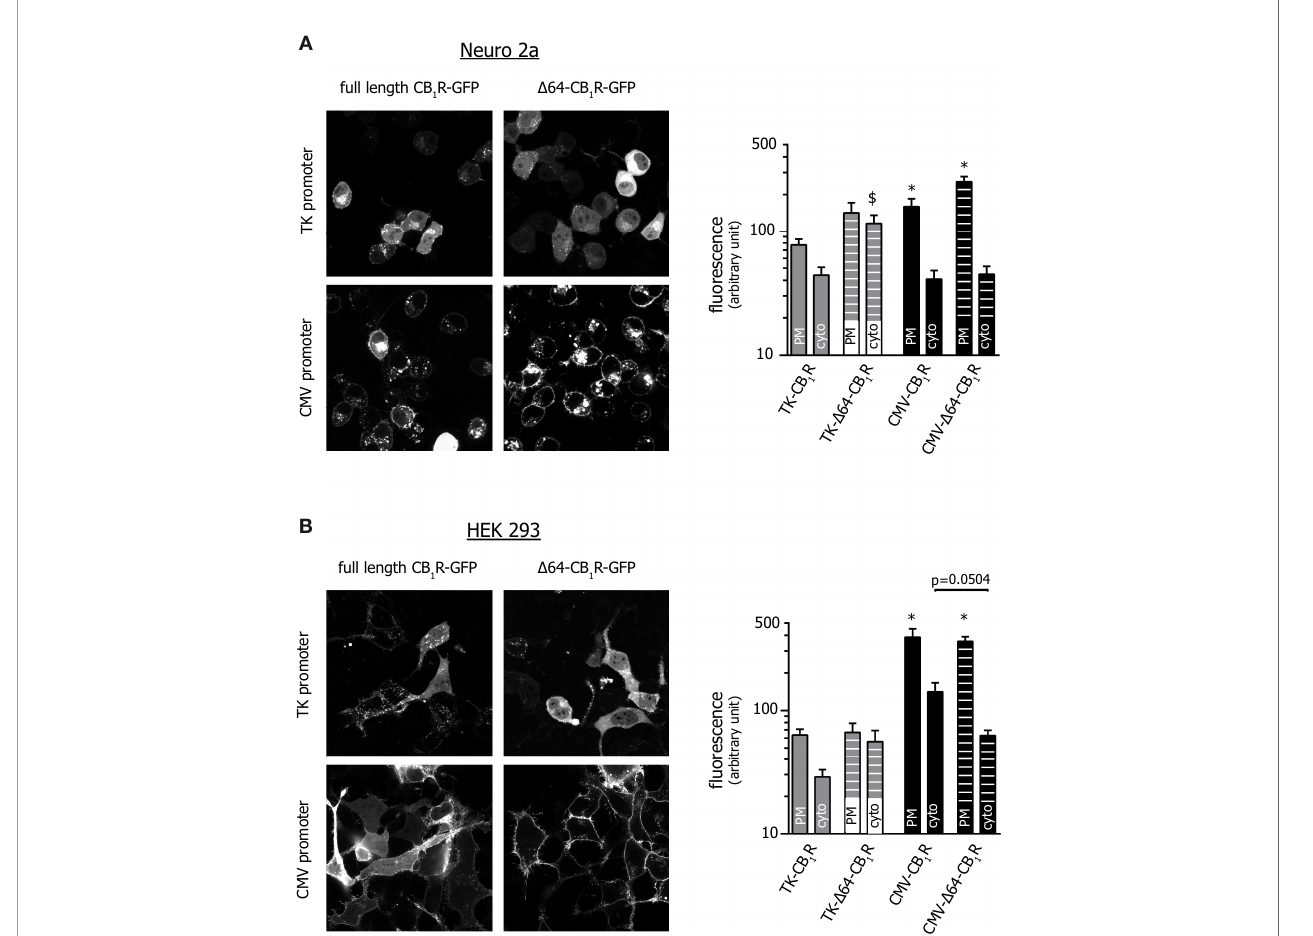
FIGURE 3 | Confocal microscopic assessment of the localization of various CB 1 R mutants. Images of Neuro 2a (A) and HEK 293 (B) cells expressing GFP-tagged versions of the pertinent CB 1 receptor variants were acquired with spinning disk confocal microscopy along the entire z-axis of the cell. Slices positioned at the bottom 1/3 ( i.e. close to the cell-coverslip interface) are presented and show an area of approx. 100 x 100 µm. (Please note that due to the signi fi cant differences in expression, the brightness of images showing TK promoter-driven receptor variants was increased to a higher extent.) Bar graphs show average plasma membrane and cytosolic fl uorescent intensity after background subtraction. In all groups n=16; *p < 0.05 when compared to TK-CB 1 R PM (one-way ANOVA followed by Dunn ’ s or Holm-Sidak ’ s multiple comparisons test for Neuro 2a and HEK 293, respectively), $ p = 0.012 vs . TK-CB 1 R-cyto (one-way ANOVA and Dunn ’ s test), for the comparison between CMV-CB 1 R-cyto and CMV- D 64-CB 1 R-cyto one-way ANOVA and Holm-Sidak ’ s test were